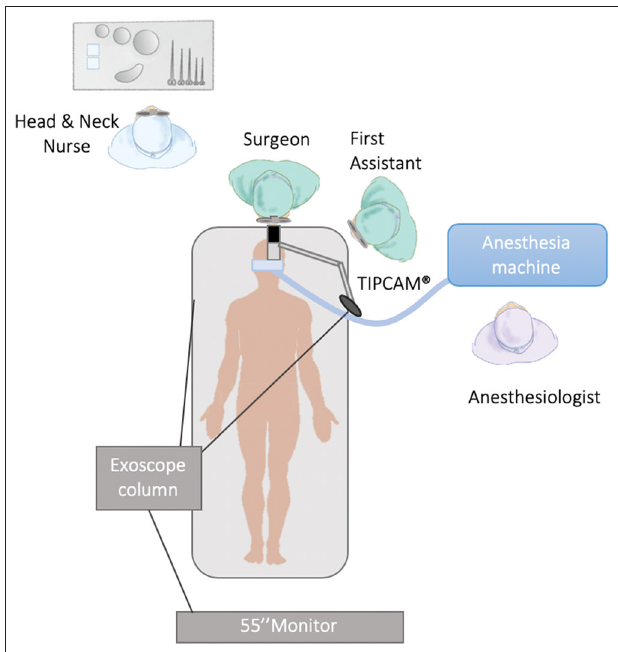
FIGURE 2 | Operating room setting (TIPCAM ®